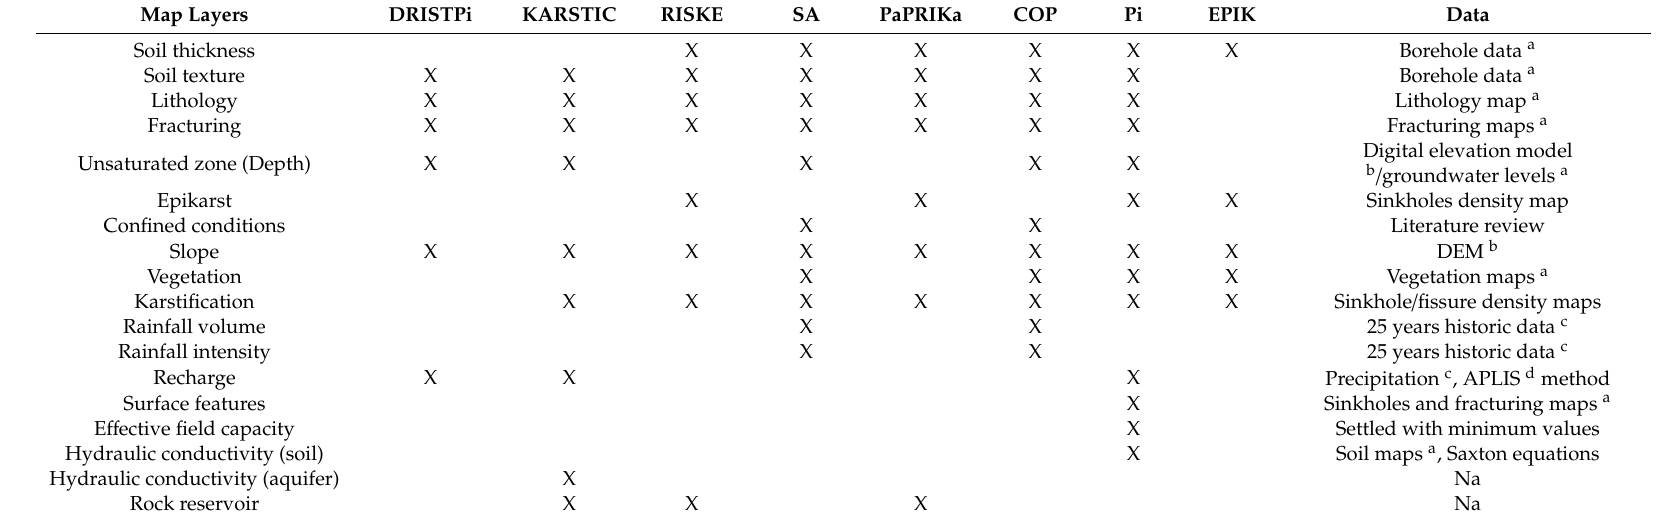
Table 1. Data utilized to create map layers for the four methods presented here and those presented previously by Moreno-G ó mez [10]. Map